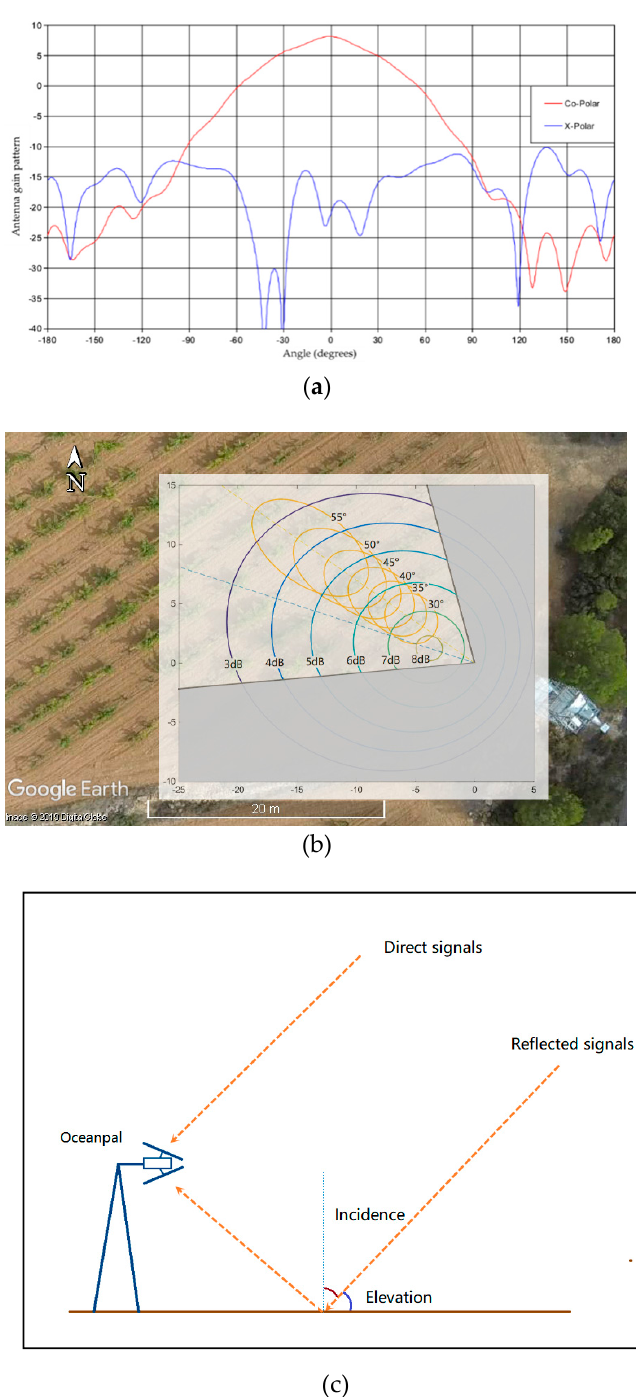
Figure 2. ( a ) Oceanpal antenna gain pattern; ( b ) projection of Oceanpal gain pattern and ELBARA-II footprint overlay on Google Earth. The upper layer shows the projection of the Oceanpal down-looking antenna’s gain over the soil surface, together with the ELBARA footprint, and the bottom layer is a photo taken by a camera drone overlay on the Google Earth base map; ( c ) The incidence angle is the complementary angle of elevation, as shown in the graph.